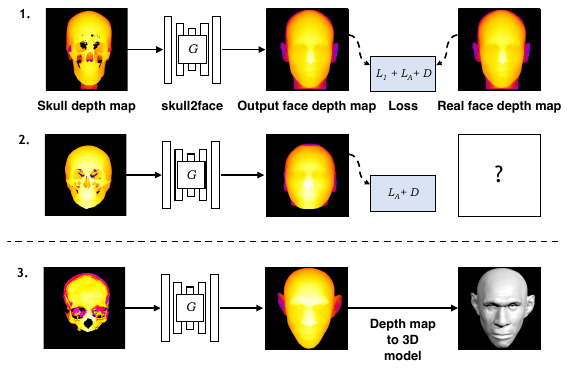
Figure 1. Overview of the proposed skull2face model: (1) training on the paired dataset, (2) training on unpaired dataset from skull depth maps and anthropological loss function, (3) testing the model